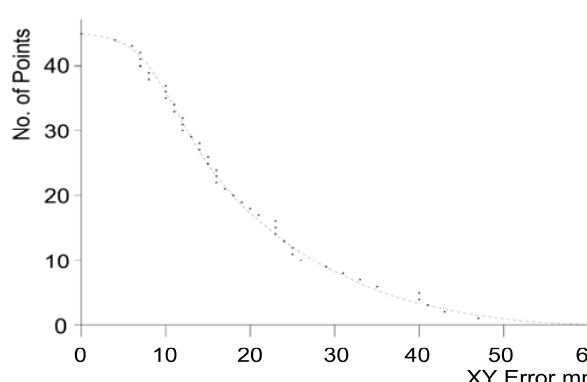
Figure 9: The planametric distribution of errors derived from the figures in the table shown in figure 7.